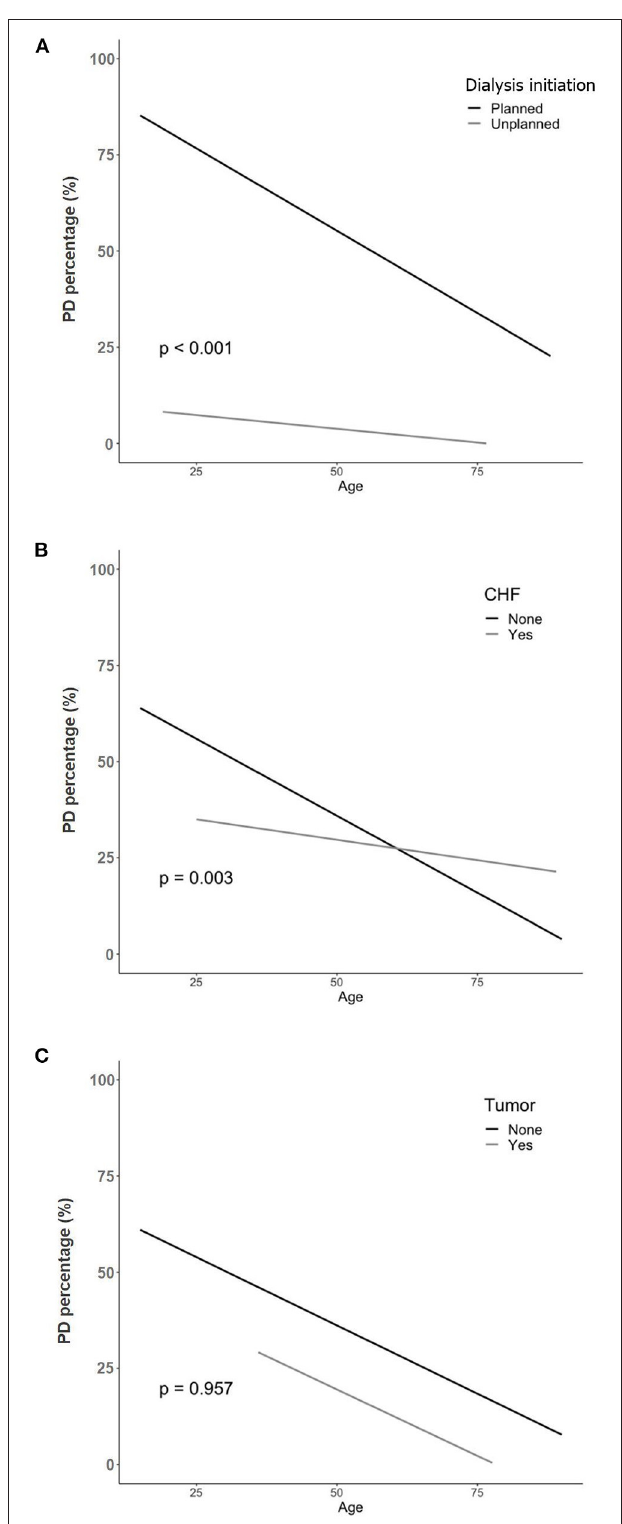
FIGURE 2 | The interaction between age and other factors on selection of PD. (A) Age and planned dialysis. (B) Age and congestive heart failure. (C) Age and the history of a tumor. PD, peritoneal dialysis; CHF, congestive heart